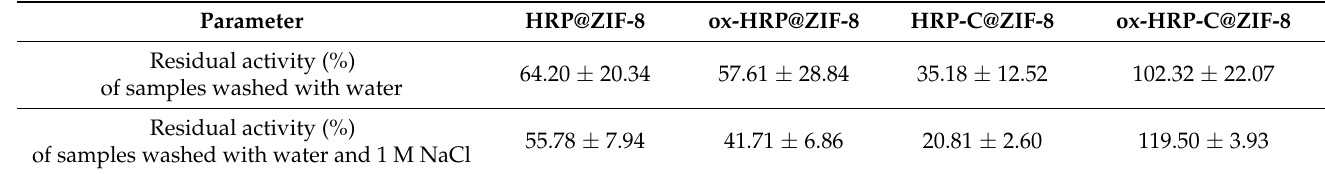
Table 4. Thermal stability of four types of biocomposites washed with water, and additionally with a 1 M NaCl solution, expressed as residual activity (%; defined as a ratio of specific activity after and before incubation at 60 ◦ C for 1 h). Residual activity of soluble HRP, HRP-C, ox-HRP, and